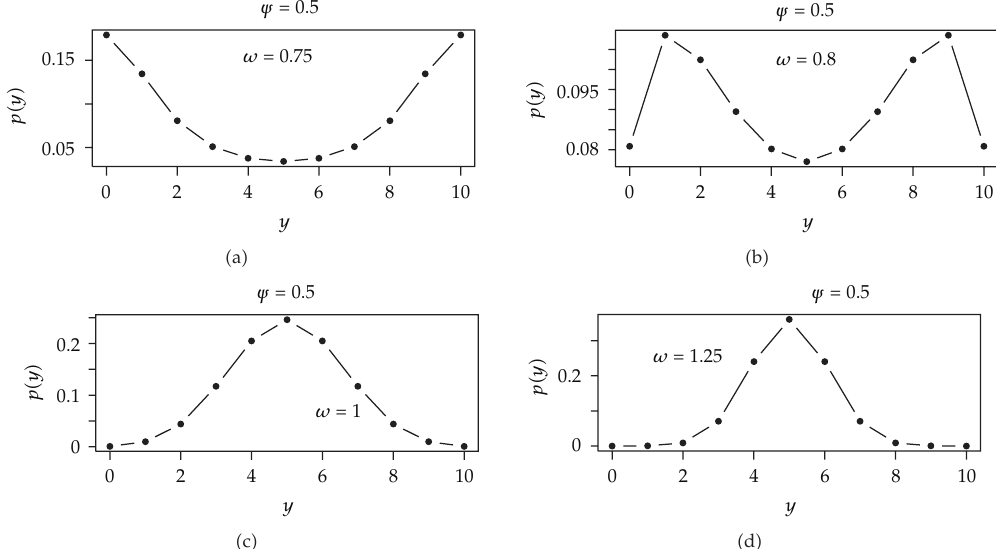
Figure 2: The distribution of Y n for di ff erent values of ω , ψ (cid:5) 0 . 5, and n (cid:5)